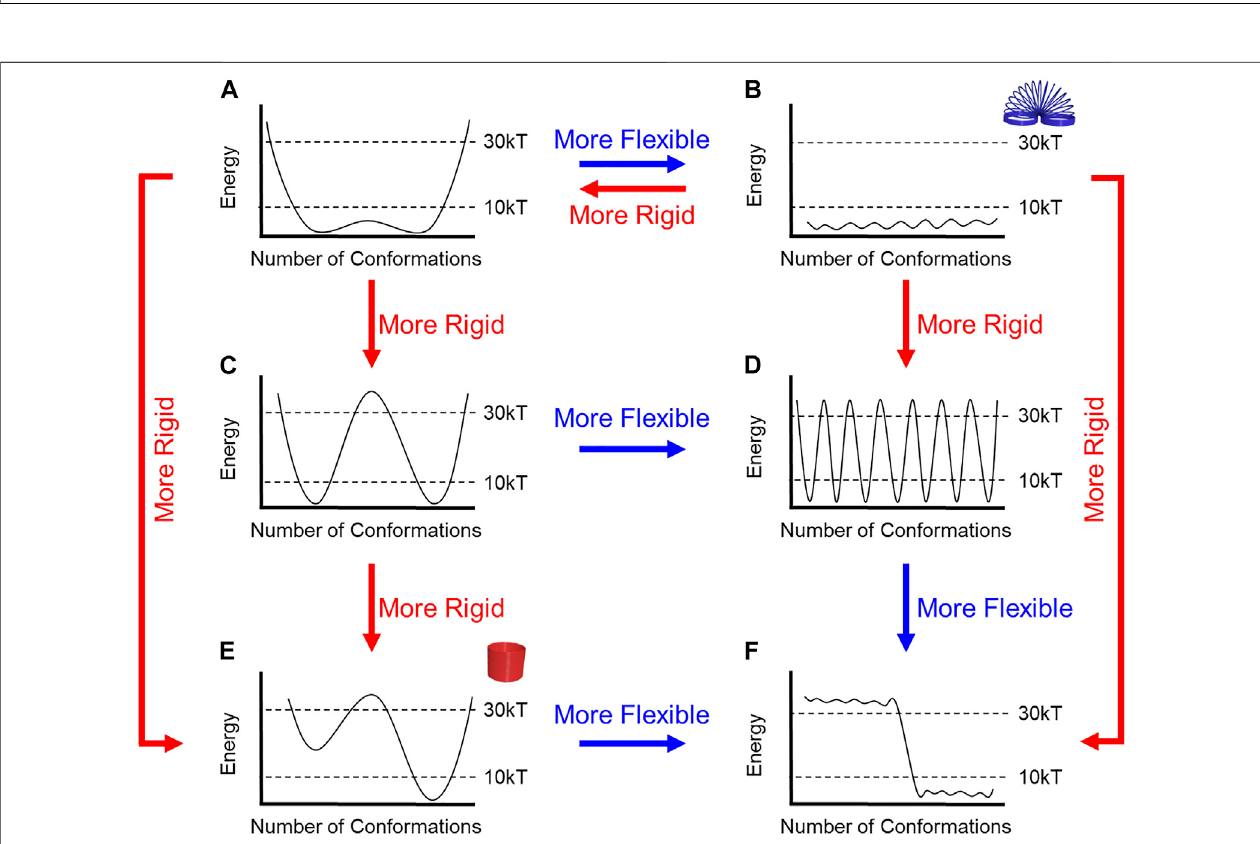
FIGURE 4 | (A – F) Flow chart to describe relative rigidity and fl exibility for energy diagrams based upon barrier heights and the number of energetically accessible conformations.